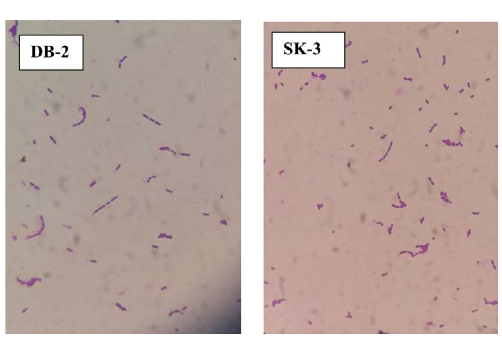
Fig. 1. Micrograph of L. plantarum DB-2 and SK-3